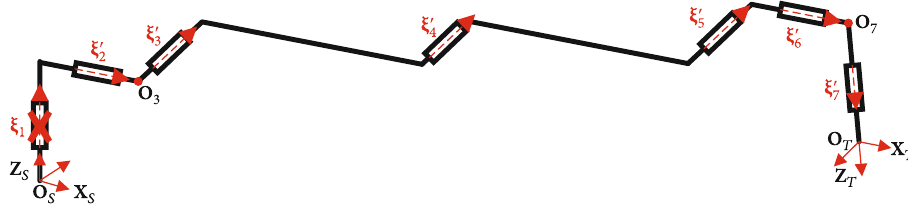
Figure 5: The reconstructed 6-DOF manipulator for locking the 1st joint.